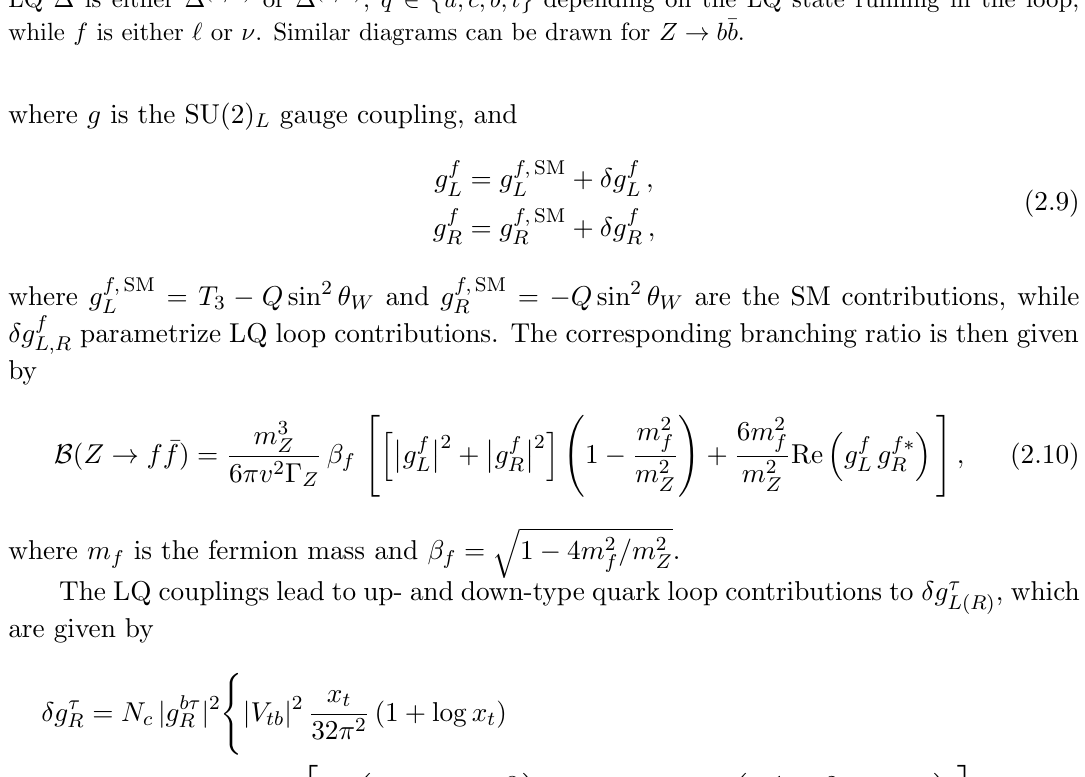
Figure 3 . Contributions to the Z LQ (cid:1) is either (cid:1) (2 = 3) or (cid:1) (5 = 3) , q while f is either ‘ or (cid:23) . Similar diagrams can be drawn for Z